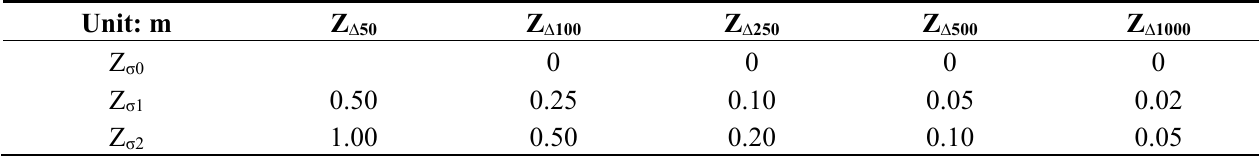
Table 1. RMSE of the synthetic floodplain elevation maps in Figure 2 with respect to 50 m benchmark and nonerror elevation map (Z ∆ 50, σ 0